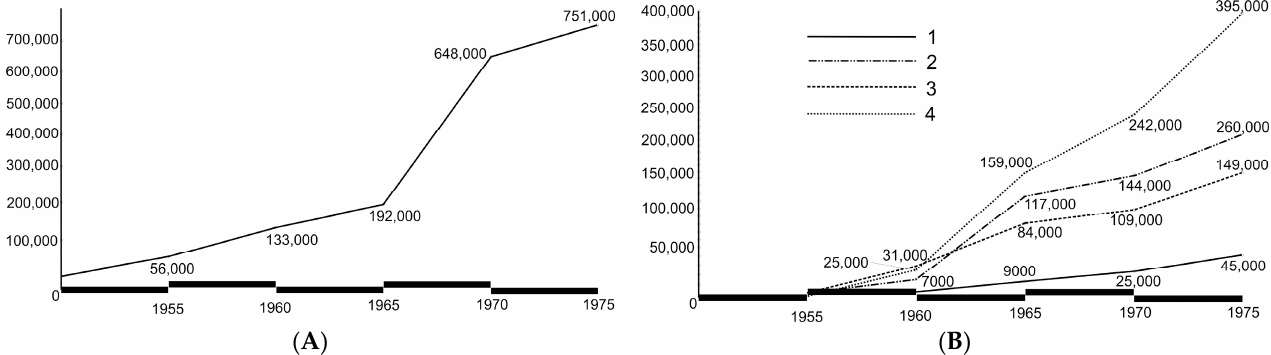
Figure 2. The rise in the standard of living (1955–1975) as reflected in: ( A ) the construction of new housing, ( B ) vehicles and consumer goods: 1. “Dacia” cars, 2. refrigerators, 3. washing machines, 4. TVs. Charts designed by Radu S ă geat ă , 2021, based on data sources from [15].